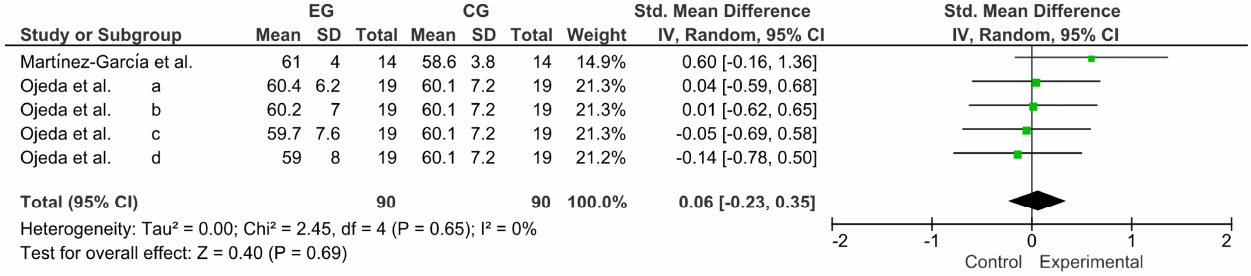
Figure 6. Forest plot comparing the effects of training with VR on time in sprint tests [31,35,46,49].